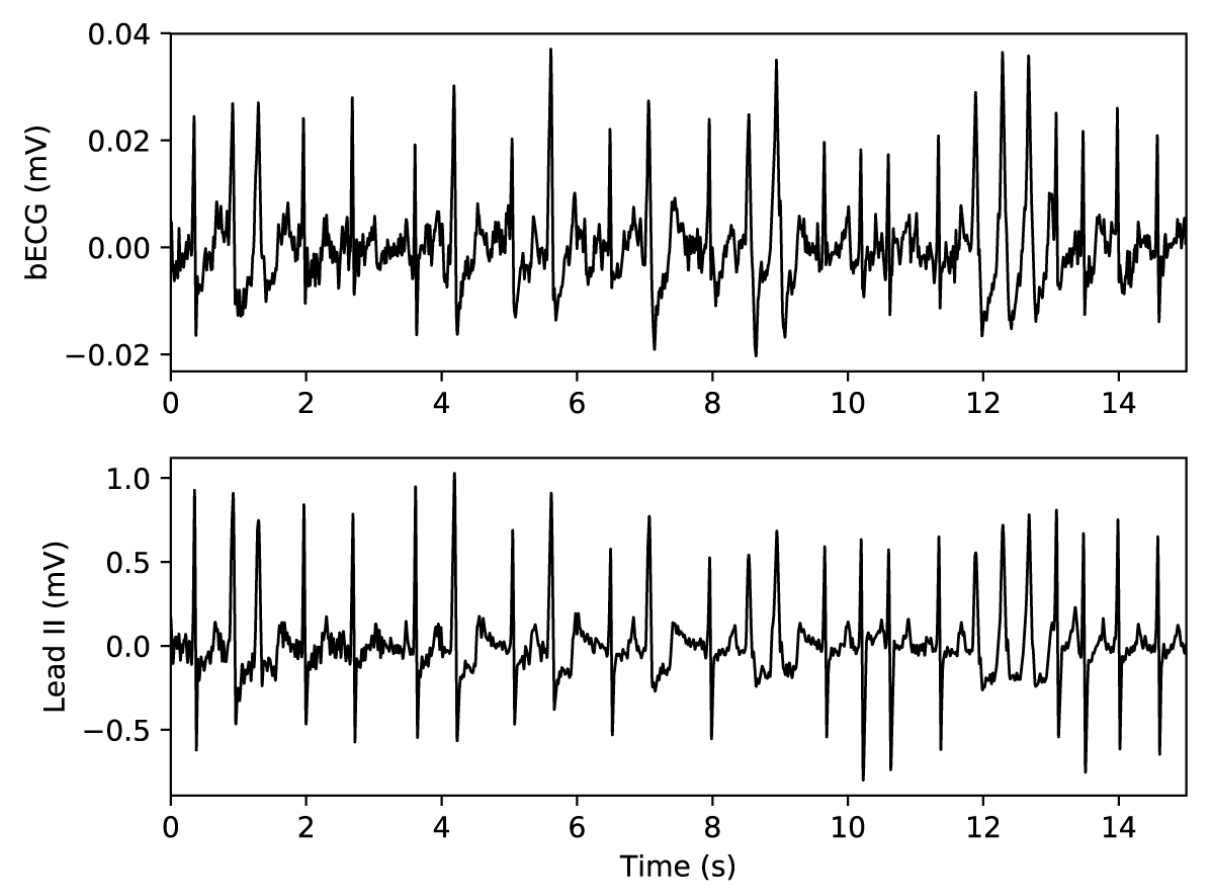
Figure 7. An example waveform from a heart failure subject during a period of arrhythmia, demonstrates that the bECG has sufficient quality to perform single-lead based rhythm analysis for those with disease states. bECG: buttocks